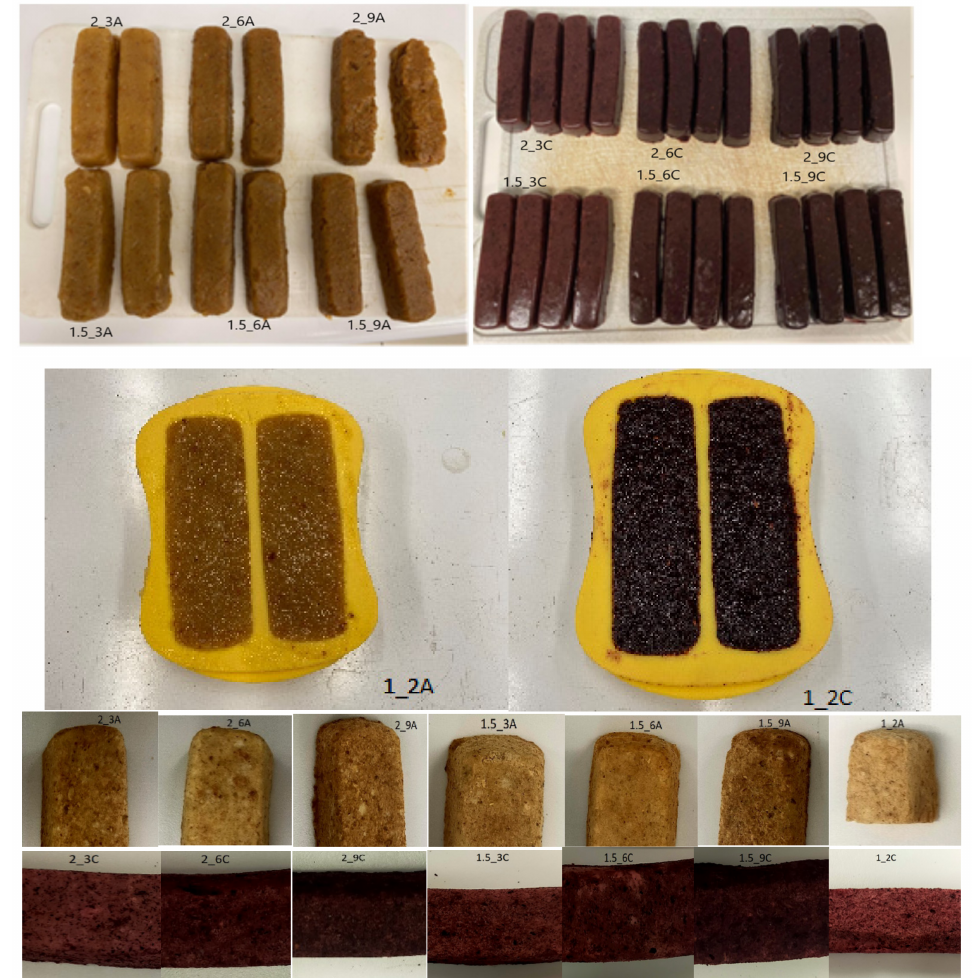
Figure 9. Photos of bars with apple pomace (A) and chokeberry pomace (C) after gelation and after freeze-drying. Denotations in Table 1 include Index (A) next to the sample symbol—bars with the apple pomace, Index (C) next to the sample symbol—bars with the chokeberry